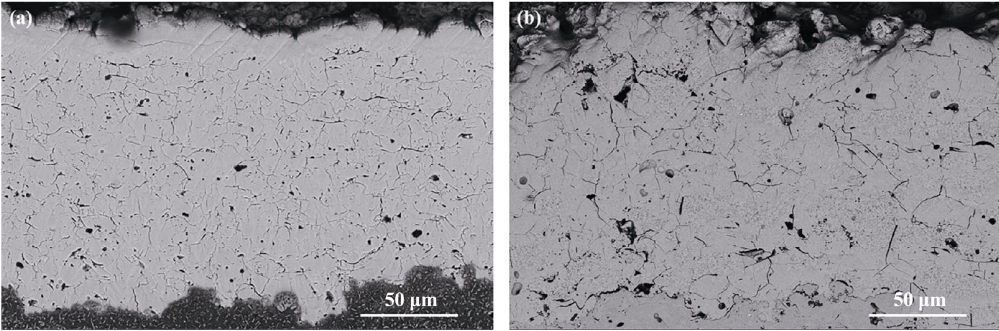
Fig. 2 SEM images from cross-sections of (a) YSZ coatings and (b) Al 2 O 3 –YSZ